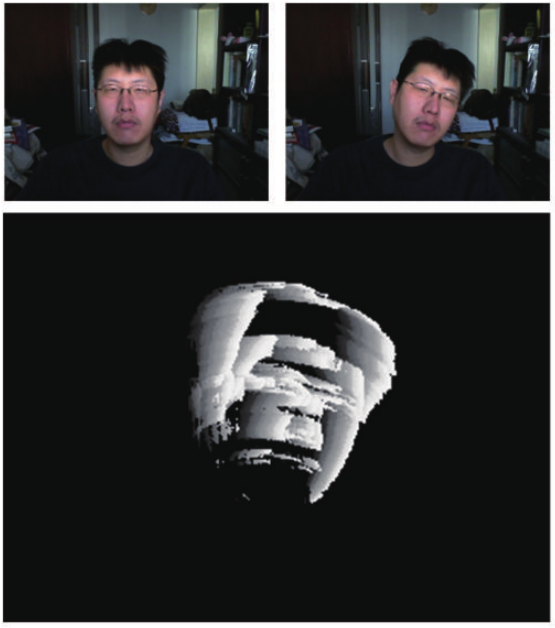
Figure 1: Motion history